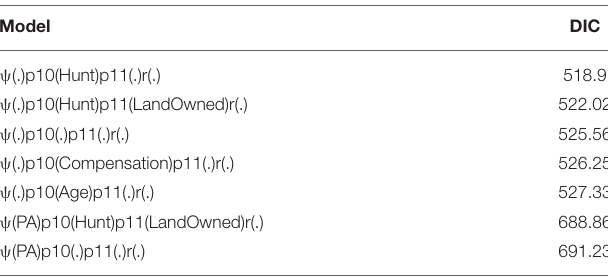
TABLE 1 | Candidate models and associated DIC values.